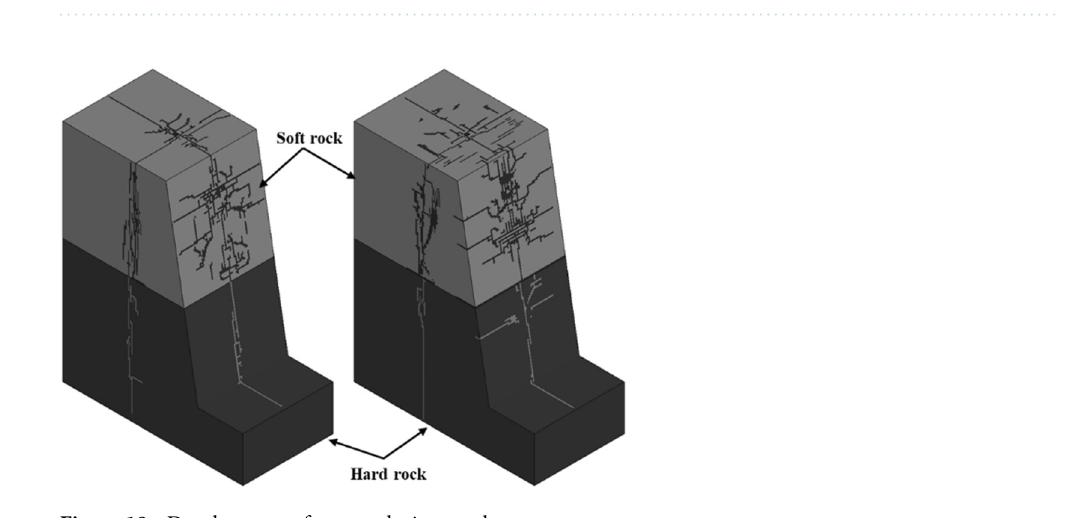
Figure 17. Stress cloud diagram of 2D model of deep hole blasting.